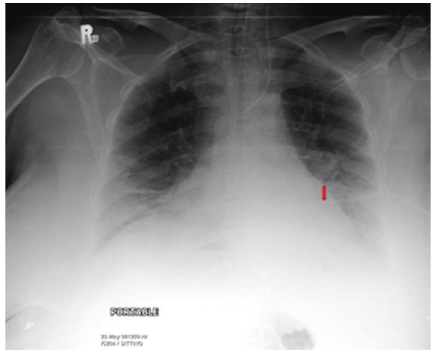
Figure 28: It shows a portable chest radiograph on an intensive care patient that developed pleural e ff usions. A chest drain was placed to drain the left-sided pleural e ff usion. Bright red blood was obtained from the tube. A CT scan (Figure 30) obtained immediately revealed the tip of the catheter had entered the left ventricle. The patient was immediately taken for cardiac surgery and the tube was removed without